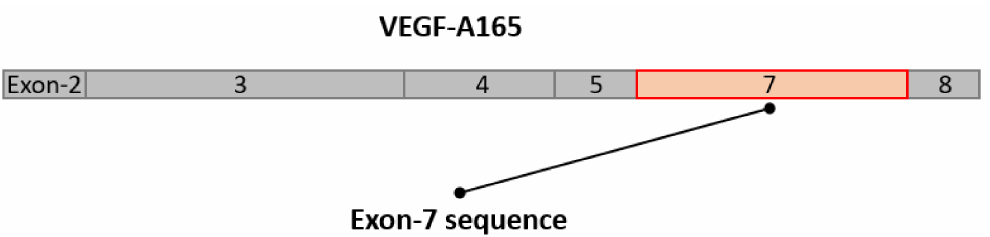
Figure 1. Exons of VEGF-A165, in which exon-7 provides the ability to bind fibronectin. A VEGF-blocking peptide (VBP) was made with the amino acid sequence derived from exon-7. Amino acid numbers in the VEGF-A165 sequence are also labeled at two VBP